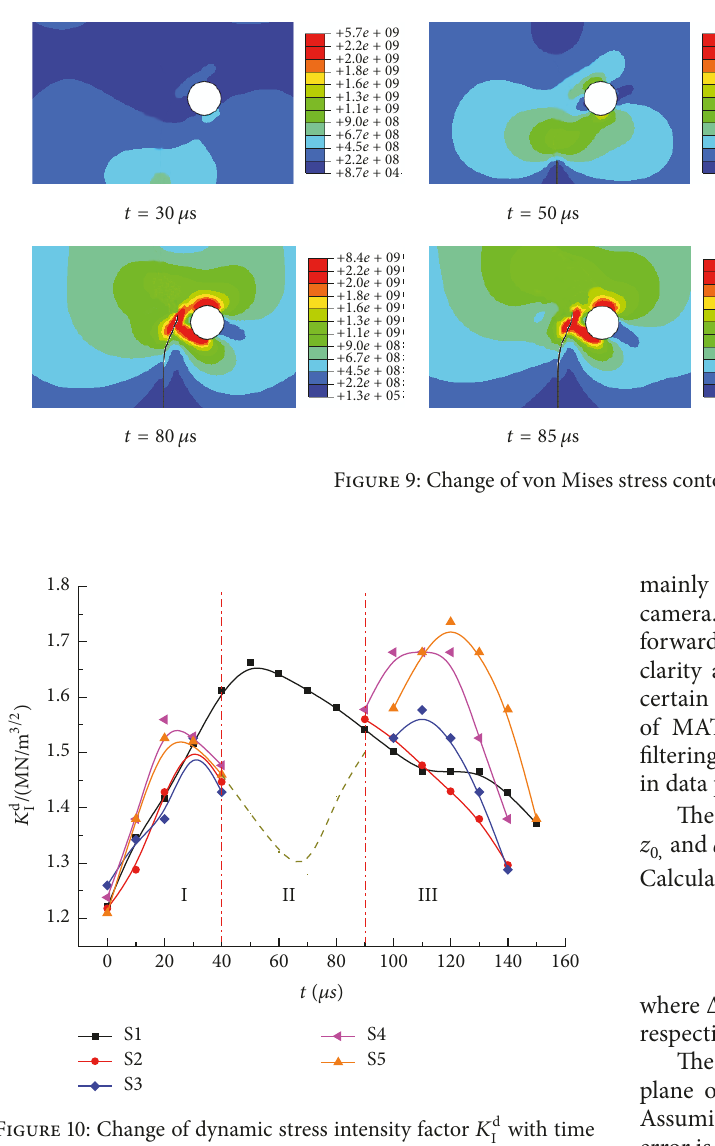
Figure 10: Change of dynamic stress intensity factor 𝐾 d Ι with time 𝑡